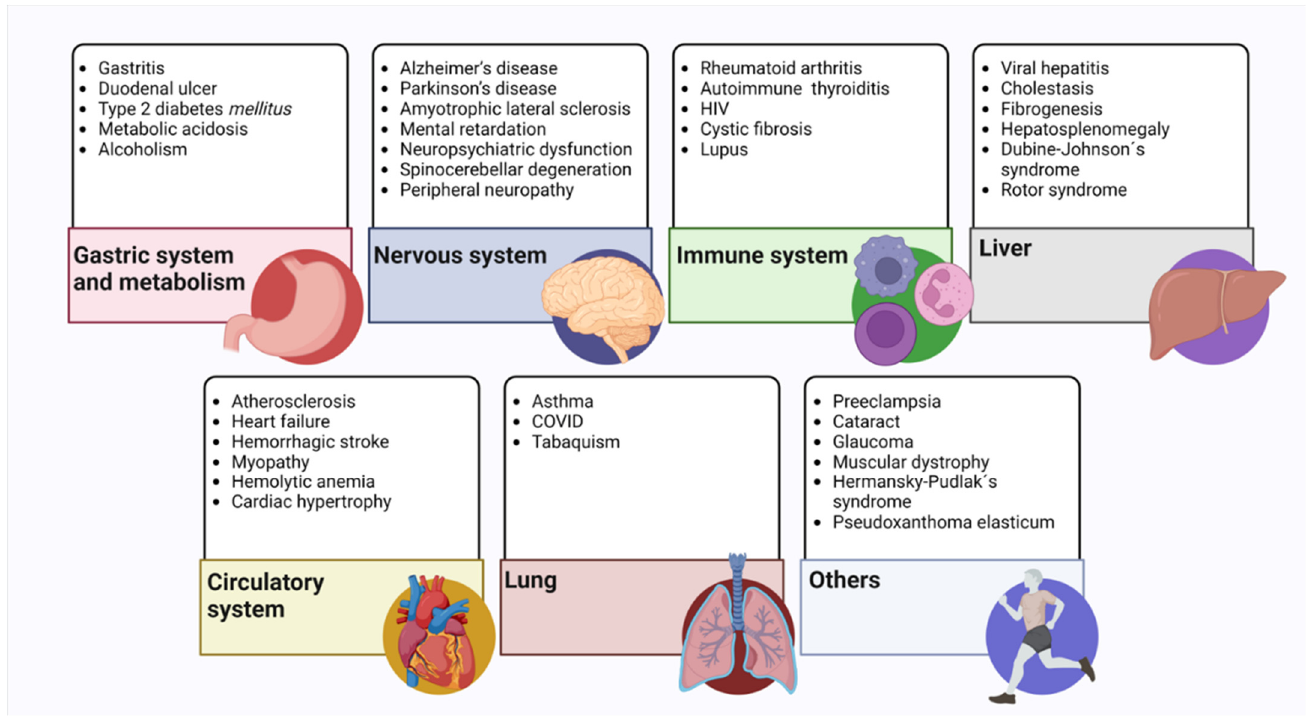
Figure 4. Pathologies related to the decrease in glutathione levels. These are mainly illnesses that cause a decrease in endogenous glutathione levels. All the pathologies mentioned in the text are classified according to the system or organ involved [81,82,87,95,96,98,119,130,132,134,148–152] .